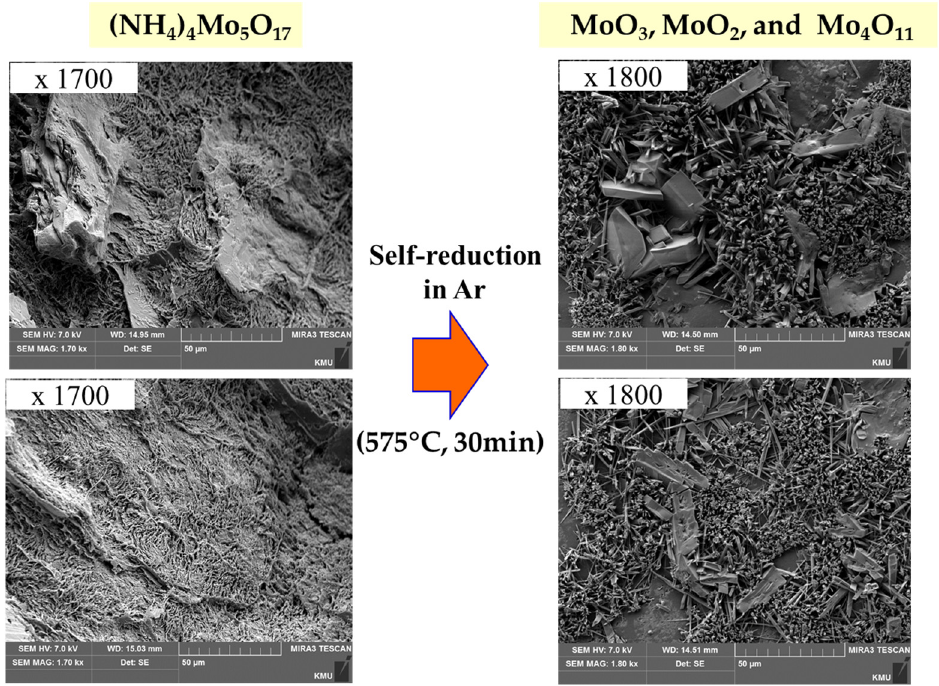
Figure 7. SEM images before and after the transformation of (NH 4 ) 4 Mo 5 O 17 to molybdenum oxides by self-reduction at 575 °C for 30 min in Ar atmosphere.